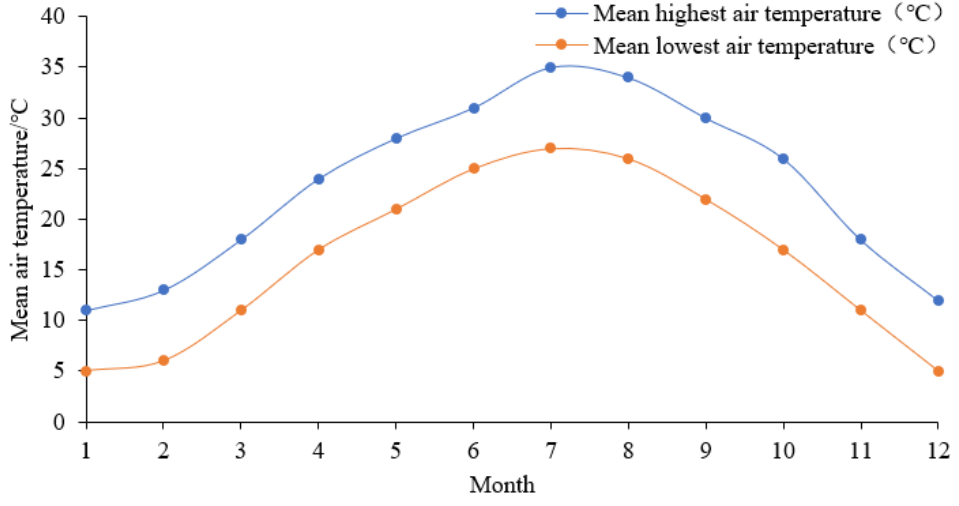
Figure 3. The annual variations of the air temperature in southern Hunan.